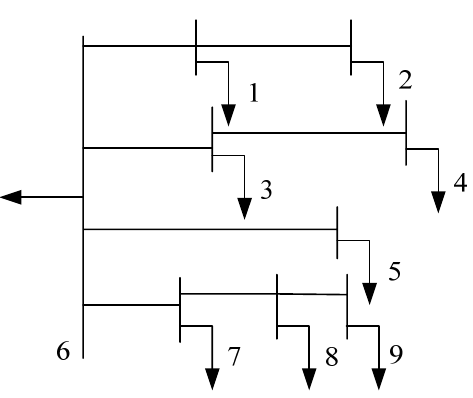
Figure 7. An example system.